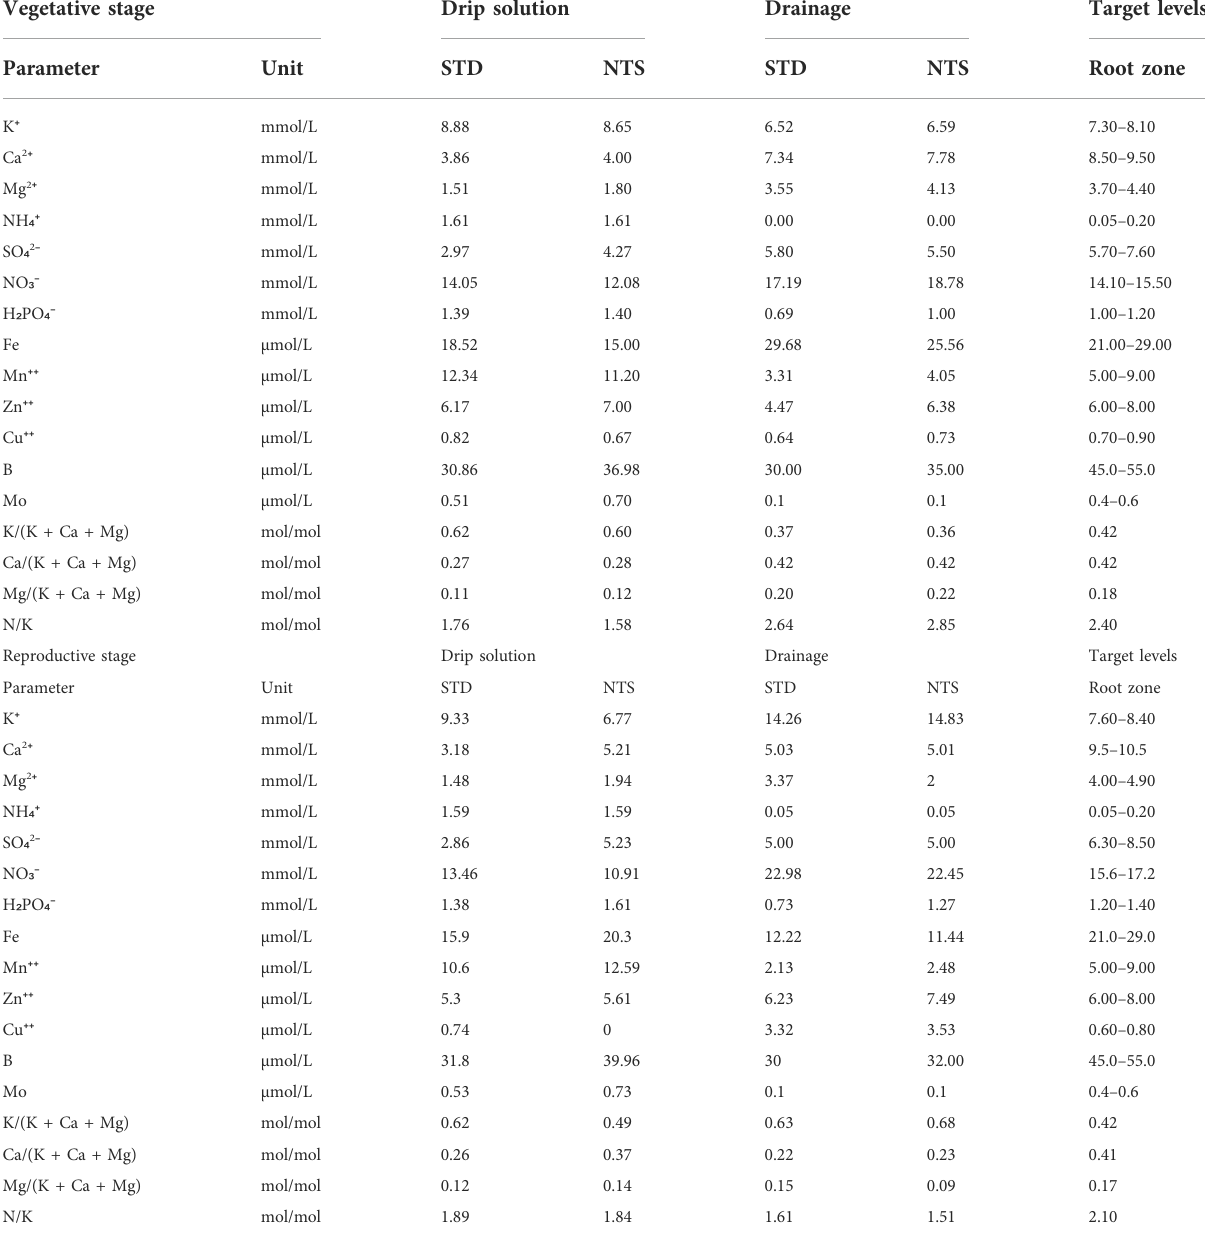
TABLE 2 Nutrient solution compositions provided by two nutritional strategies (i.e., standard-STD and NUTRISENSE-NTS) in hydroponic tomato crops during the vegetative and reproductive stage. Vegetative